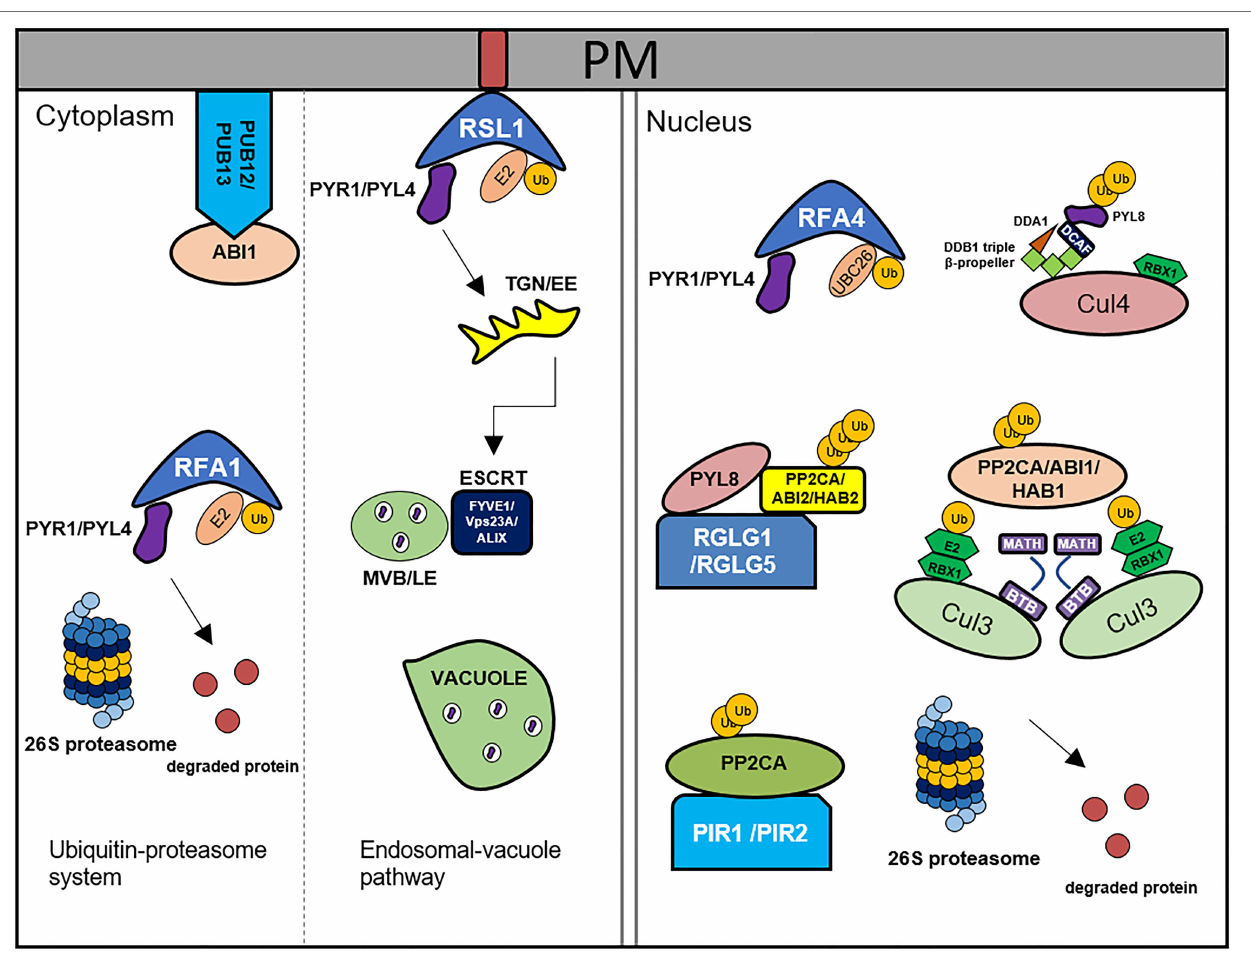
FIGURE 1 | Degradation of ABA core components by the 26S ubiquitin-proteasome system and endosomal-vacuole pathway. PYR1/PYLs are degraded by RSL1, RFA1/RFA4, and CRL4 DDA1 through ubiquitin-proteasome system. RSL1 ubiquitinates PYR1/PYL4 on the plasma membrane (PM), after that ubiquitinated substrates are degraded by ESCRT components, FIVE1/VPS23A/ALIX via endosomal-vacuole pathway. RFA1- and RFA4/CRL4 DDA1 -mediated ubiquitination processes occur in the cytosol and nucleus, respectively. PP2Cs are degraded by PUB12/13, CRL3 BPM3/5(BTB-MATH) , PIR1/2, and RGLG1/5 through 26S proteasome. PUB12/13 degrade ABI1 by ubiquitination in the PM. RGLG1/5 ubiquitinate PP2CA/ABI2/HAB2, CRL3 BPM3/5(BTB-MATH) ubiquitinate PP2CA/ABI1/HAB1, and PIR1/2 ubiquitinates PP2CA in the nucleus. This figure has been modified from Coego et al.